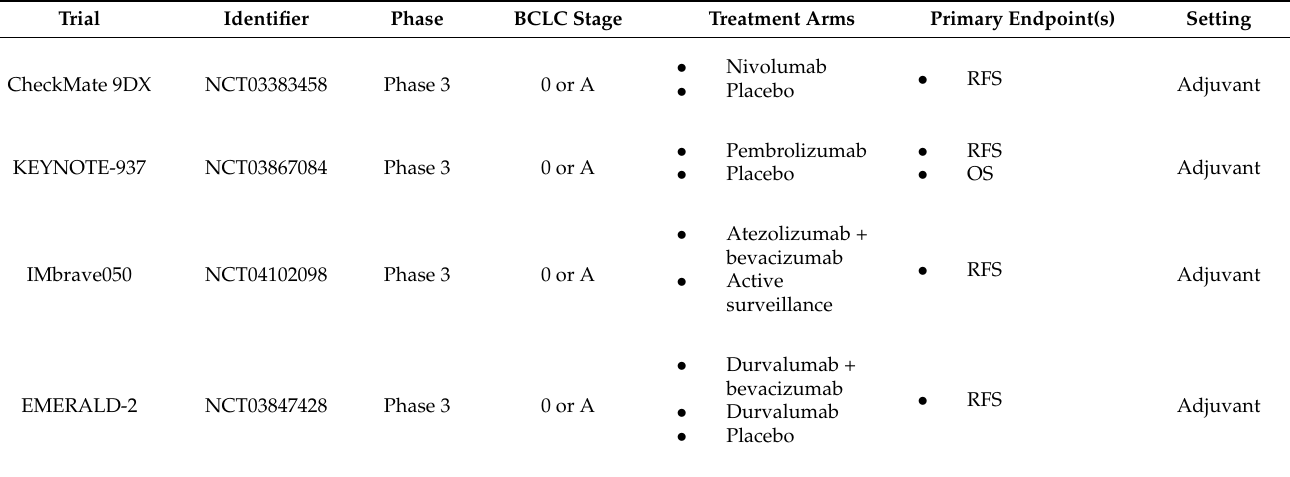
Table 4. Current clinical trials on adjuvant systemic treatments after surgery or